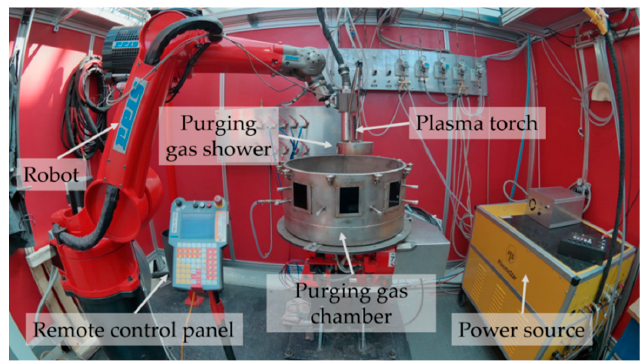
Figure 1. Experimental setup for 3D plasma metal deposition (3DPMD).